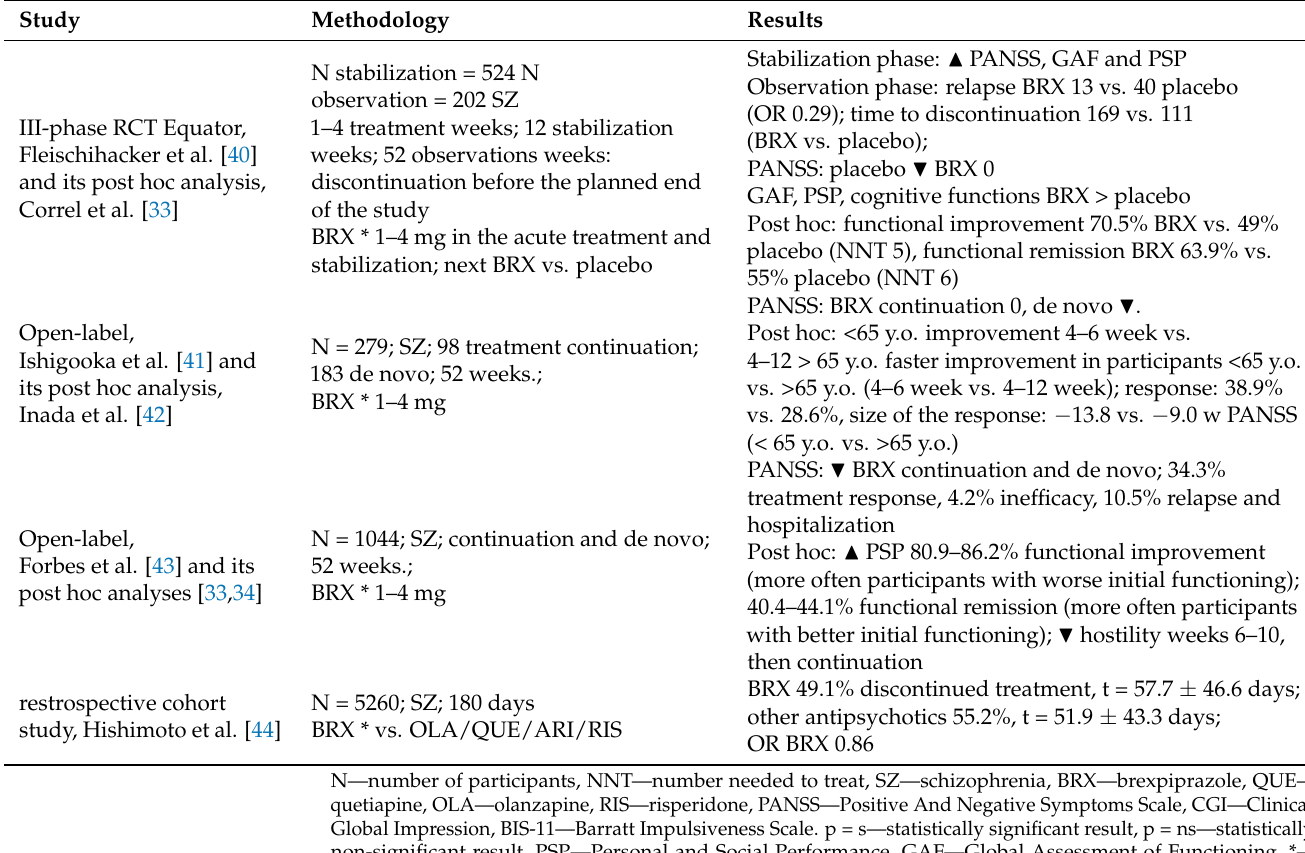
Table 3. Studies on long-term schizophrenia treatment with the use of